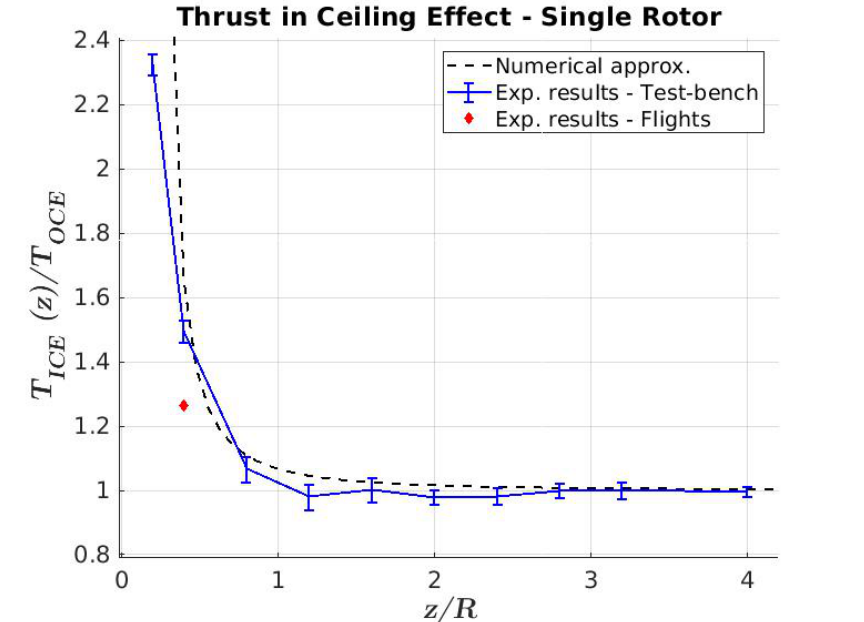
Figure 15. Ceiling-factor results. The blue error bar shows the experimental results obtained in a test bench, the black curve is the numerical approximation, and the red marker represents the ceiling factor obtained with the flight data.